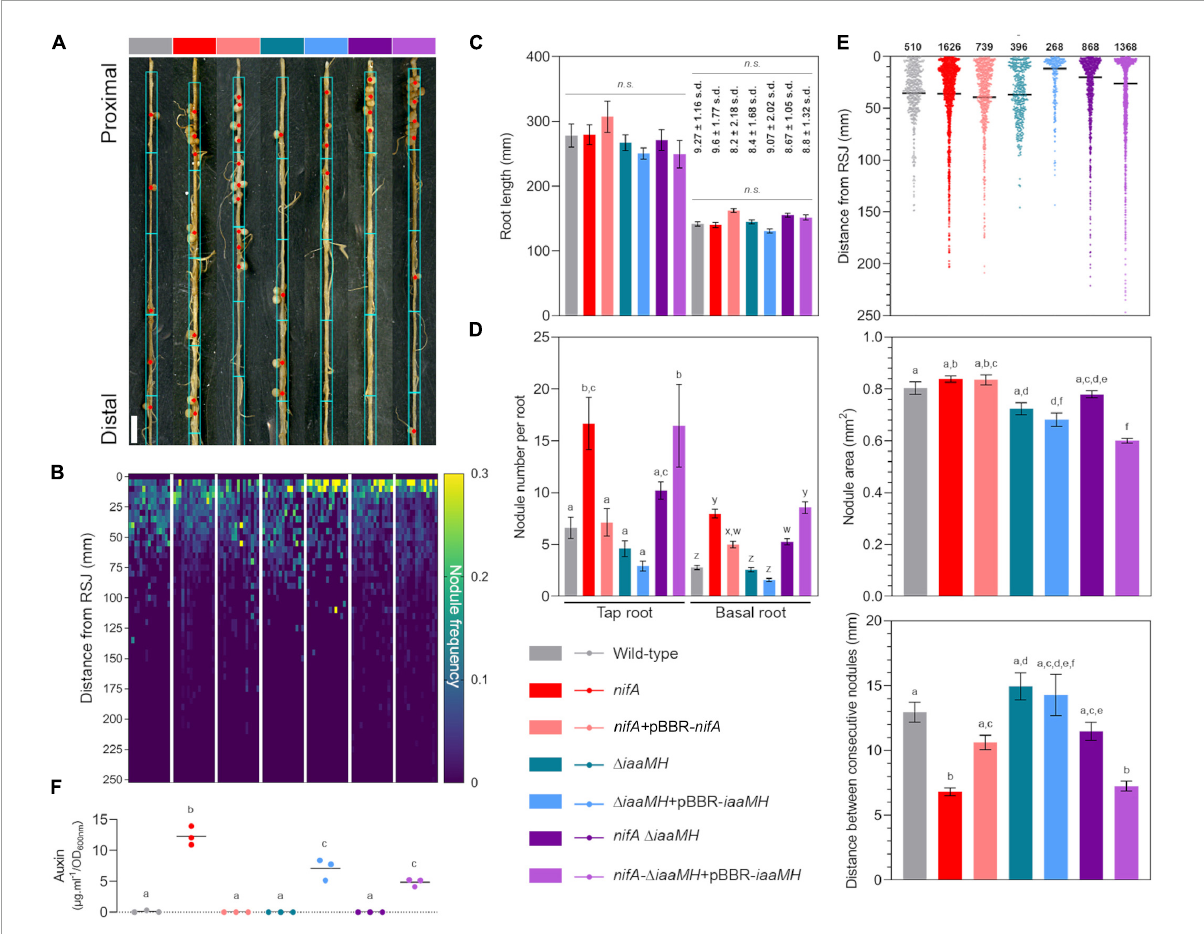
FIGURE7 Detailed characterization of Paraburkholderia phymatum-Phaseolus vulgaris symbiosis nodulation patterns in the presence of discrete strains. (A) Representative 21 dpi P. vulgaris basal roots infected with the indicated strain. Red dots indicate the centroid of each single or clustered nodules. Cyan boxes illustrate the suggested nodulation windows along the root axis. Bar = 5 mm. (B) Frequency of nodulation in the entire root system of 15 individual plants in response to the given inoculants. The positions of individual nodules relative to the root-shoot junction were pooled into 5 mm bins. (C) Mean tap and basal root lengths of the sampled plants. Whiskers represent standard error. Bold numbers indicate the mean number of basal roots and standard deviation of the mean. Significant differences between samples means were analyzed with one-way ANOVA with Tukey’s post hoc test ( p -value ≤ 0.05). Same letters indicate that means are not statistically significantly different when required. n.s. , not significant. (D) Mean nodule number per root type. Whiskers represent standard error. (E) Total nodules parameters for the sampled plants. Individual dots represent single nodule position on the root axis. Black bars represent means. Whiskers represent standard error. Bold numbers indicate the total number of sampled nodules. Significant differences between samples means were analyzed with one-way ANOVA with Tukey’s post hoc test ( p -value ≤ 0.05). Same letters indicate that means are not statistically significantly different. (F) Quantification of indolics production in liquid cultures of the given strains in µ g · ml − 1 in relation to the cultures’ optical density OD 600 . Individual dots represent each different biological replicate. Different letters account for significantly different